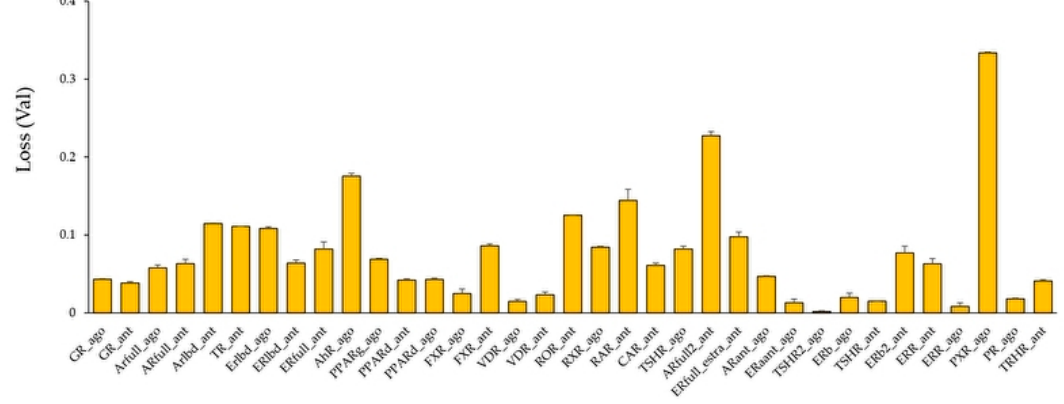
Figure 3. Average Loss values in the validation (Val) dataset in models of 35 NR agonists and antagonists constructed by DeepSnap-DL. n = 2. Each bar indicates average of Loss (Val) ± standard error.